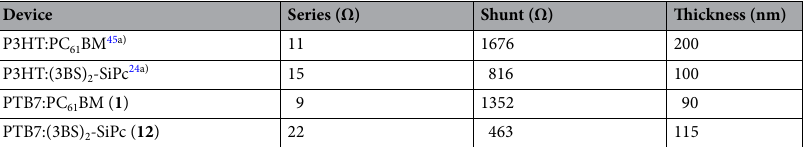
Table 2. Thickness, series and shunt resistances of the optimized devices and relevant comparative devices. a) Devices have been previously reported and further characterized here.